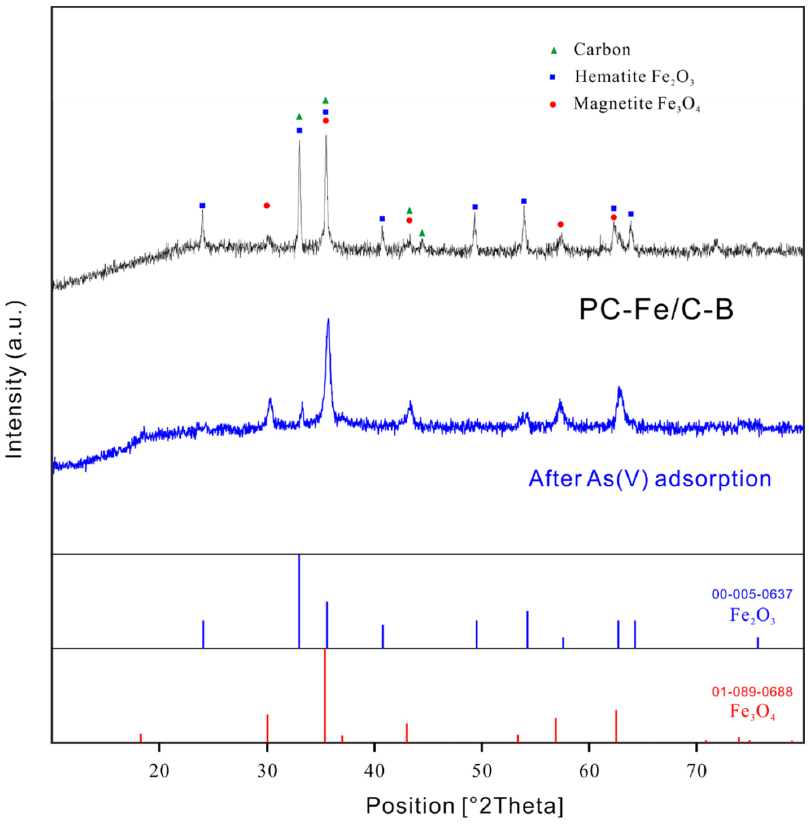
Figure 2. XRD patterns of PC ‐ Fe/C ‐ B, before and after adsorption. In the FT ‐ IR spectra (Figure 3) of PC ‐ Fe/C ‐ B after As(V) adsorption, the presence of a wide absorption peak at 3415.26 cm − 1 was attributed to the contracting vibration of − OH in the material, rather than to the dissociation of physically adsorbed water (due to the absence of a vibration peak near 1630 cm − 1 ) [35]. This, also, showed that the number of − OH groups on the surface of iron oxide increased after As(V) adsorption, which, also, confirmed the acid–base dissociation behaviour of PC ‐ Fe/C ‐ B, during the adsorption of As. After As adsorption, the intensity of the stretching vibration peak of CO 2 at 2361 cm − 1 decreased, and the C ‐ O and C=O vibration peaks [35], at 1541 cm − 1 and 1516 cm − 1 , shifted to higher wave numbers, of 1551 cm − 1 and 1532 cm − 1 , respectively. The Fe ‐ O vibration peaks, at 564 cm − 1 and 443 cm − 1 , also, shifted to lower wavenumbers, of 556 cm − 1 and 440 cm − 1 , indicating that the groups corresponding to these peaks were the active adsorption sites on the surface of PC ‐ Fe/C ‐ B. In the FT ‐ IR spectra of the PC ‐ Fe/C ‐ B sorbent after sorp ‐ tion of As(V), peaks of AsO 43 − for As–O were observed to be bending around 873.60 cm − 1 .